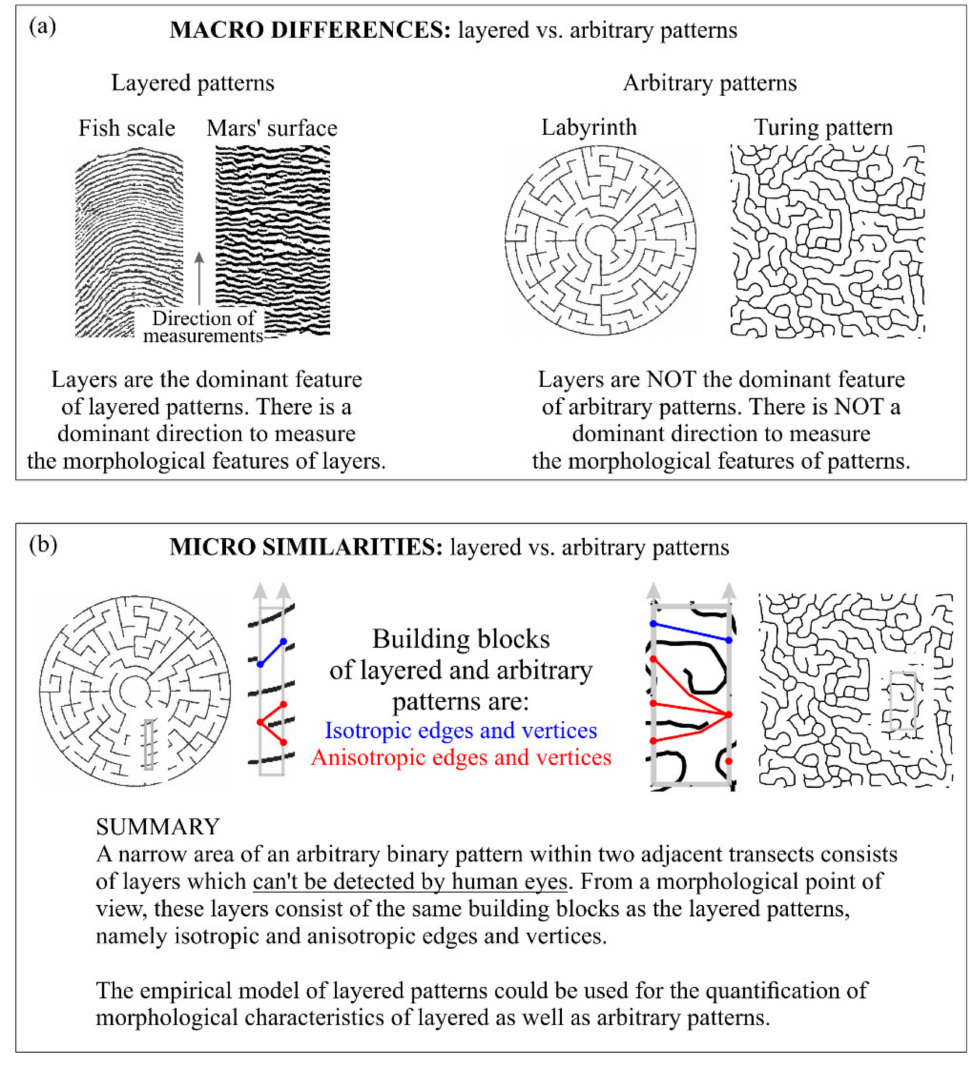
Figure 4. Differences and similarities between layered and arbitrary patterns. ( a ) Visual macro structural differences between layered and arbitrary patterns. ( b ) Non-visual micro structural similarities between layered and arbitrary